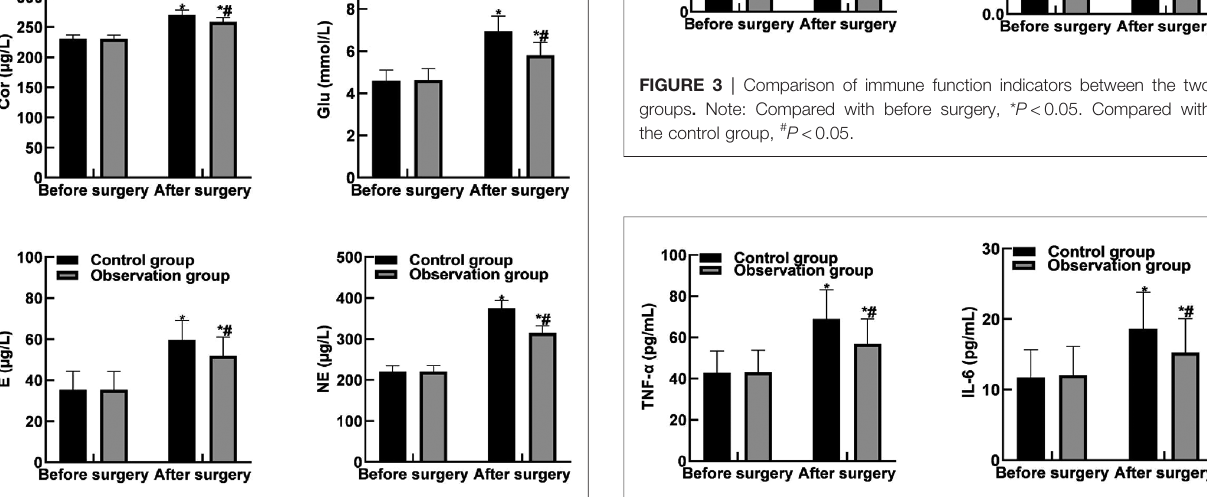
FIGURE 2 | Comparison of stress response indicators between the two groups . Note: Compared with before surgery, * P <0.05. Compared with the control group, # P <0.05.